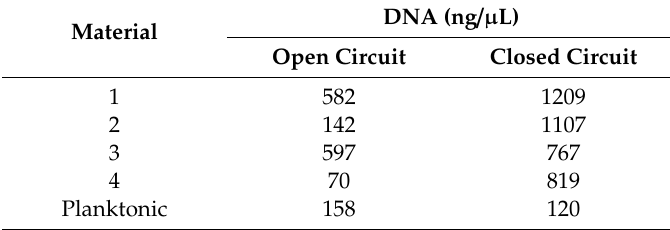
Table 2. Biofilm biomass (DNA ng / µ L) in open- and closed-circuit materials 1, 2, 3 and 4.